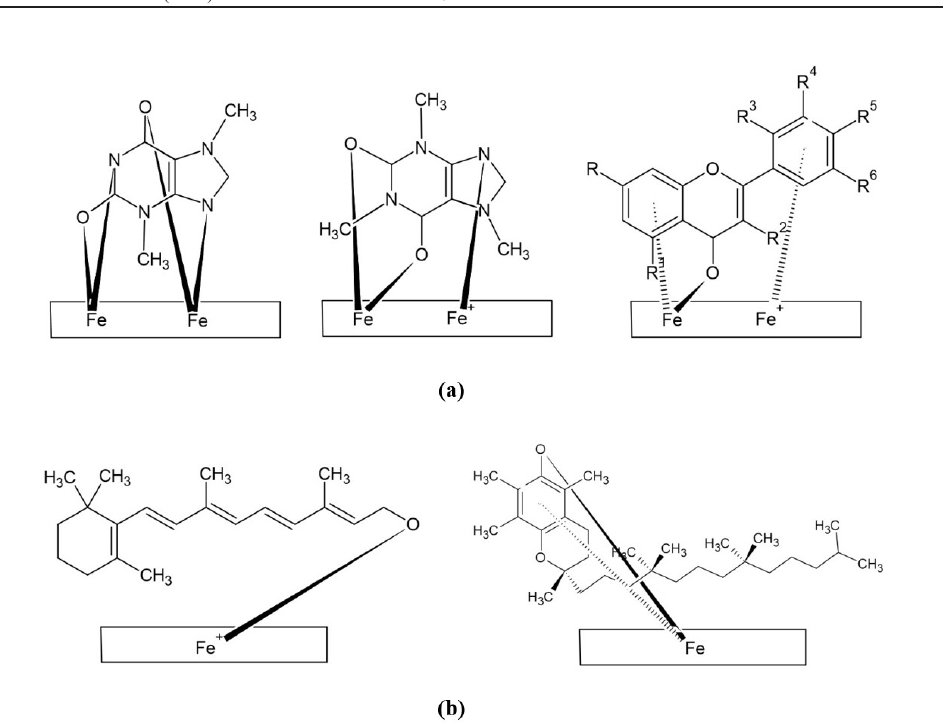
Figure 11. Skeletal representation of adsorption of Teobromina, Cafeina, Flavonoides (a), Vitamina A and Vitamina E (b) on the carbon steel ASTM 1020